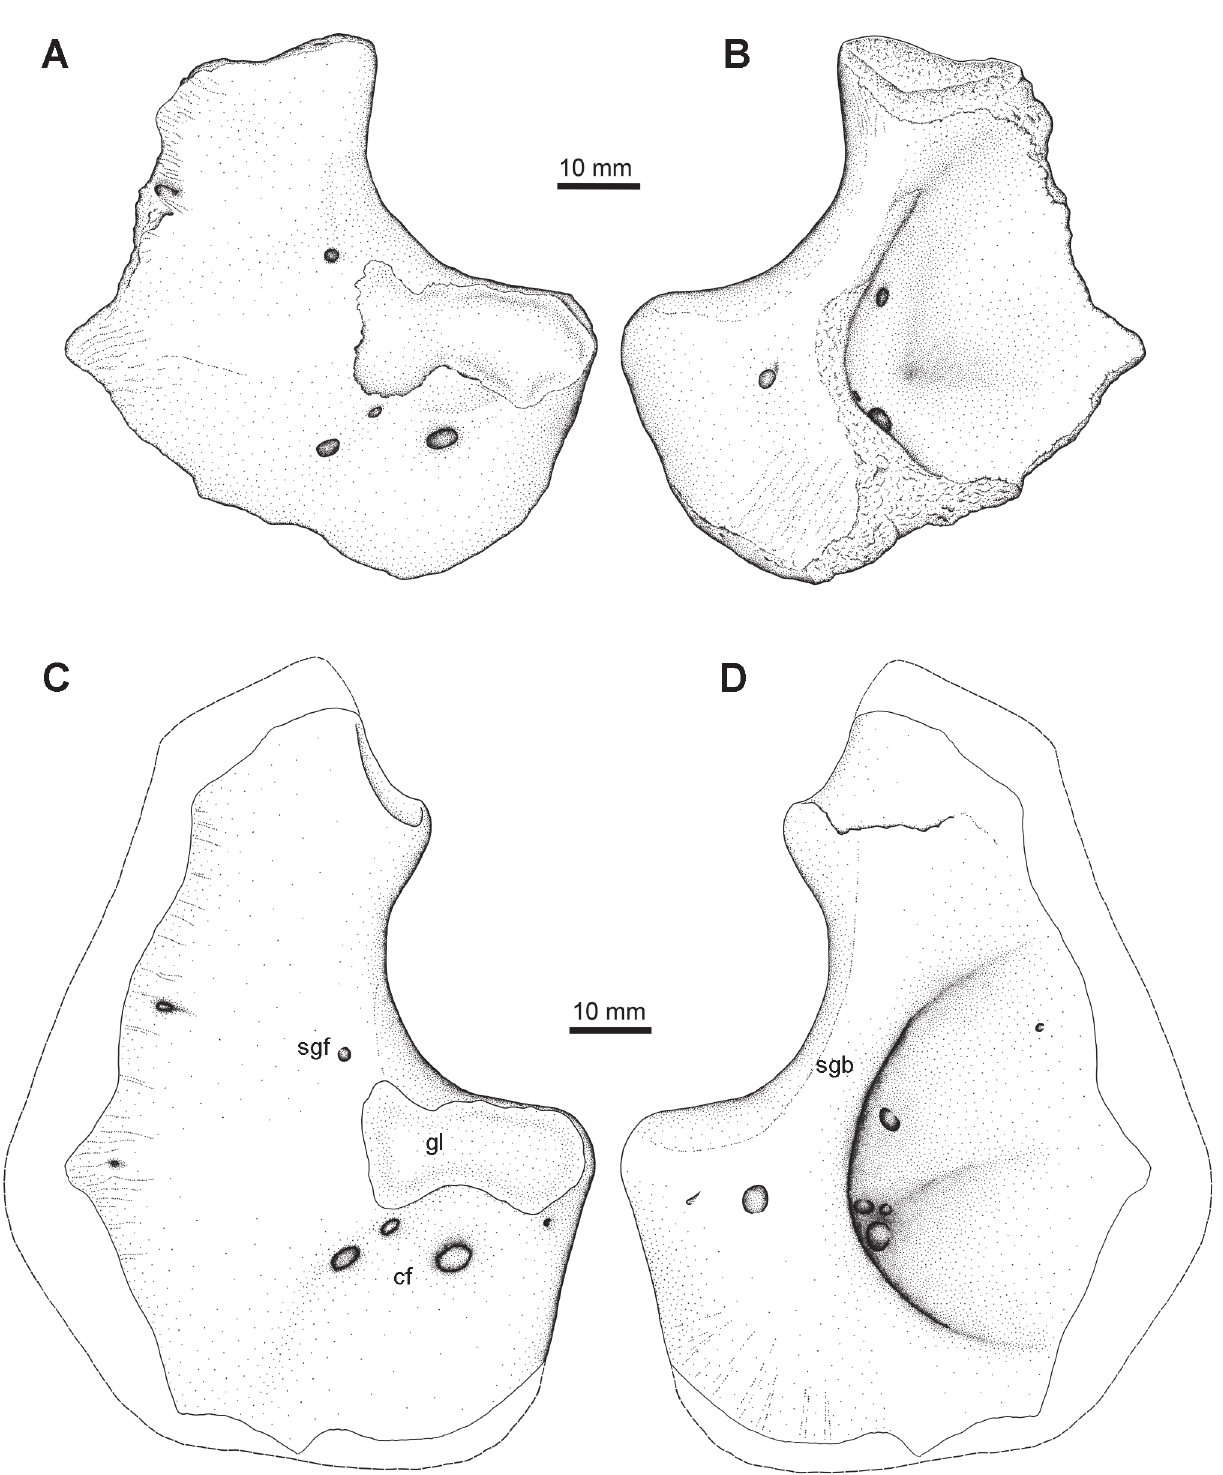
Fig 7. Scapulocoracoid Type 1. NSM005GF045.005, left scapulocoracoid in A, lateral, and B, medial views. Reconstruction of full extent of this morphotype from multiple specimens in C, lateral, and D, medial views. Abbreviations : cf , coracoid foramina; gl , glenoid; sgb , supraglenoid buttress; sgf , supraglenoid